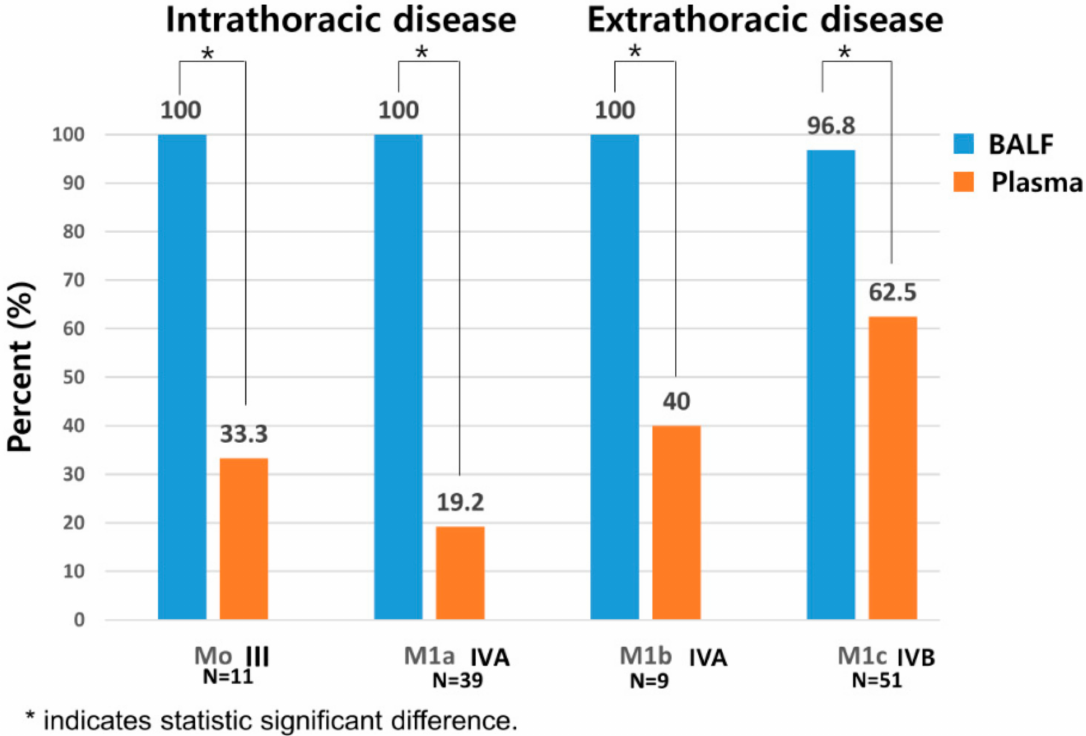
Figure 2. Comparison of sensitivity between BALF and plasma liquid biopsy depending on metastatic tumor stage. * Indicates statistically significant difference ( p < 0.05). (M0: no metastasis; M1a: in- trathoracic metastasis; M1b: single extrathoracic metastasis; M1c: multiple extrathoracic metastasis).